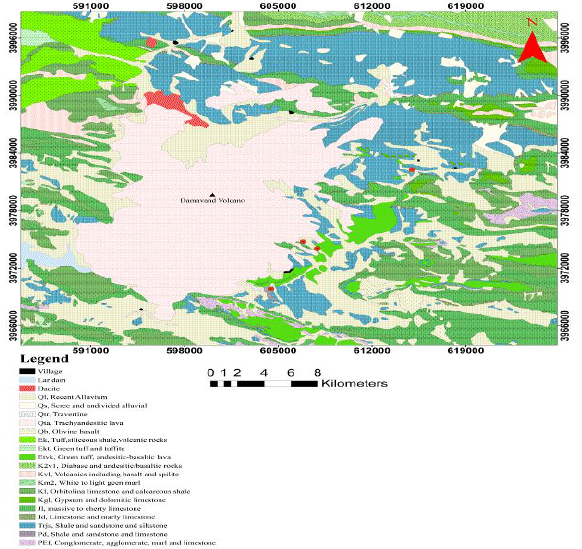
Figure 1. Geological map of Damavand volcano (digitized, compiled and simplified from1/100000 maps of Baladeh, Amol and East Tehran (geological survey of